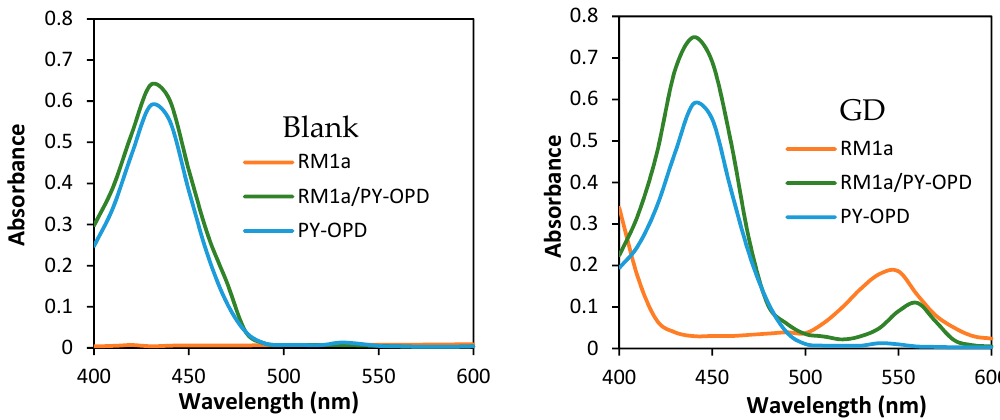
Figure 4. Absorption spectra of RM1a, PY-OPD and RM1a/PY-OPD (in chloroform solution) for blank and addition of soman (GD). Chemosensors 2019 , 7 , x FOR PEER REVIEW